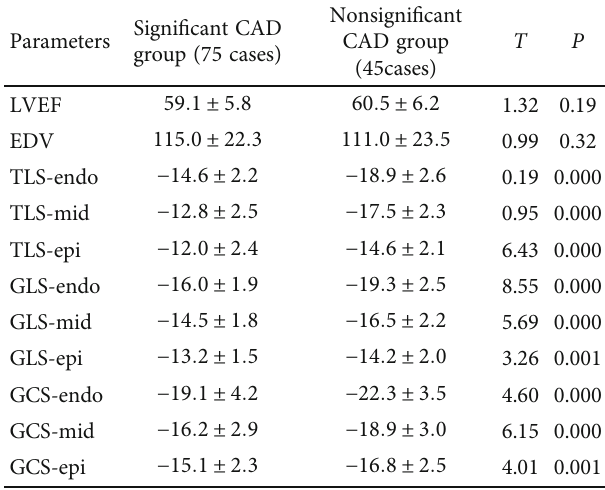
Table 2: Comparison of echocardiographic parameters.